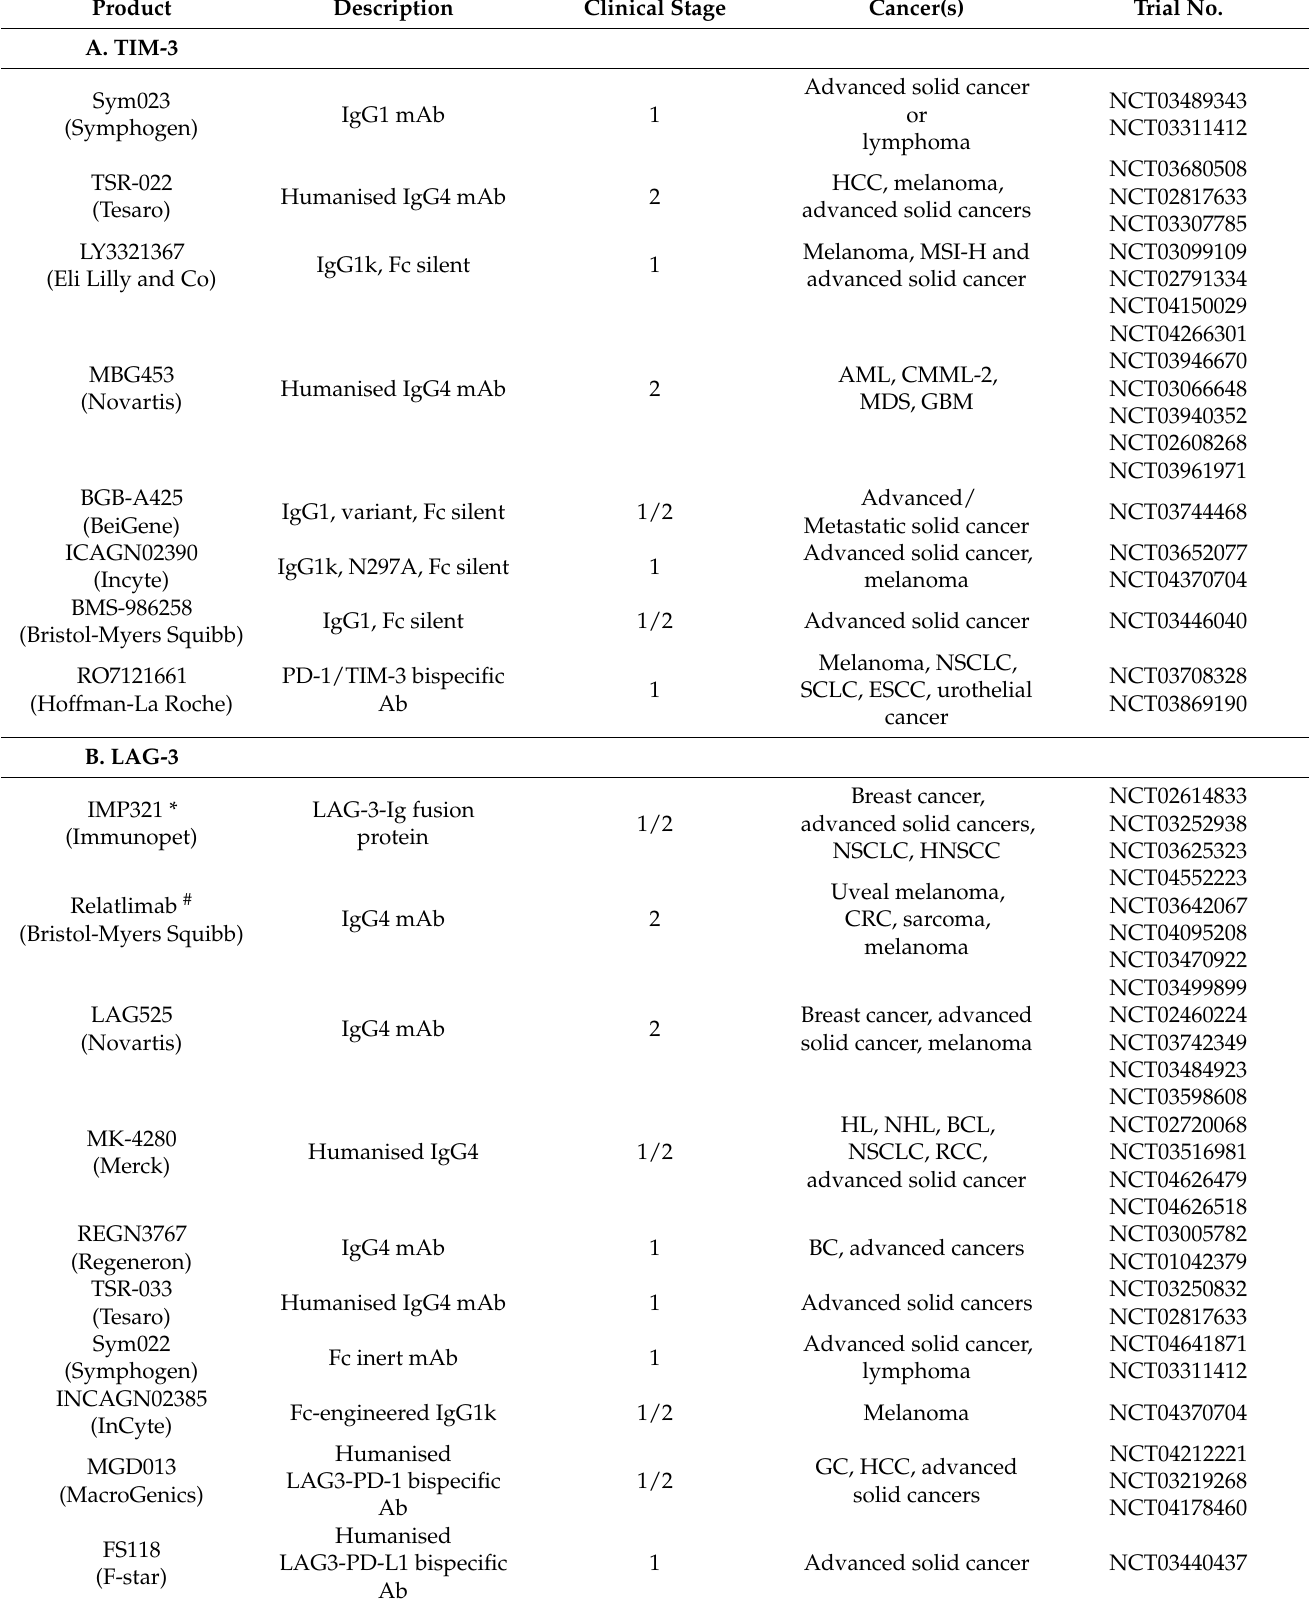
Table 1. Clinical trials underway using therapeutics against TIM-3, LAG-3 and TIGIT